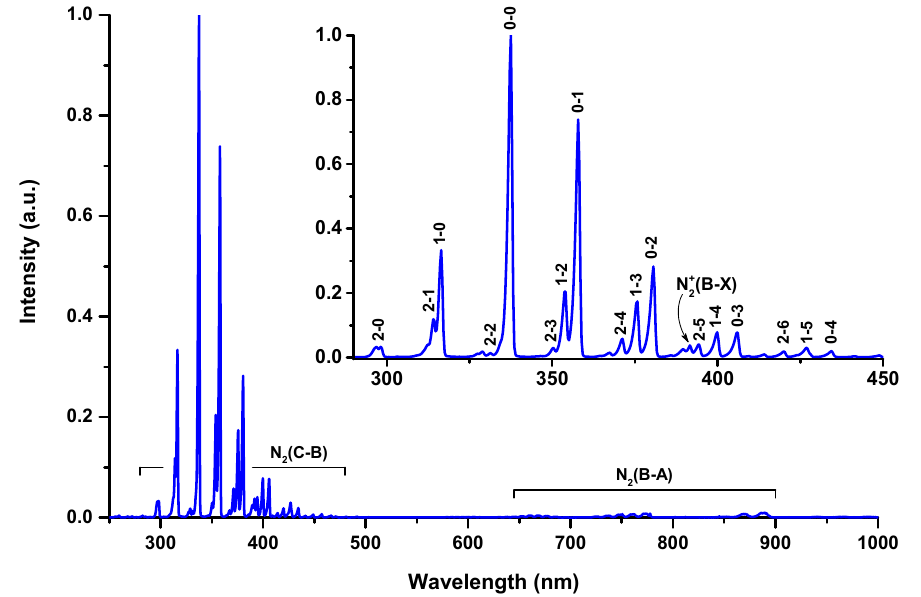
Figure 3. Typical time-integrated emission spectrum of the cometary/point-to-ring discharge. The inset shows the short-wavelength region of the emission spectrum.